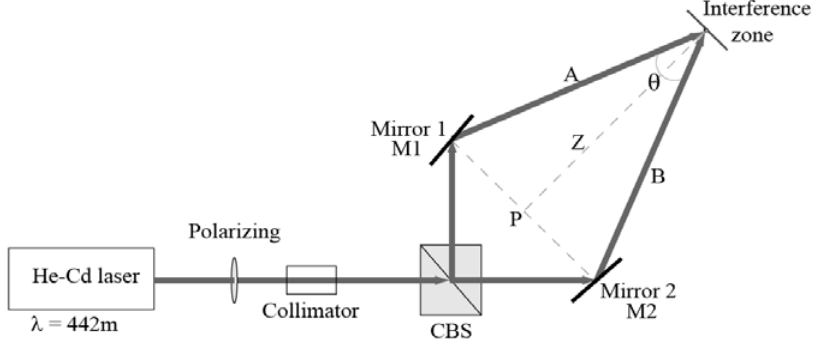
Figure 5. Experimental setup of symmetrical arms for the recording of holographic gratings. The recording beam wavelength was  = 442nm